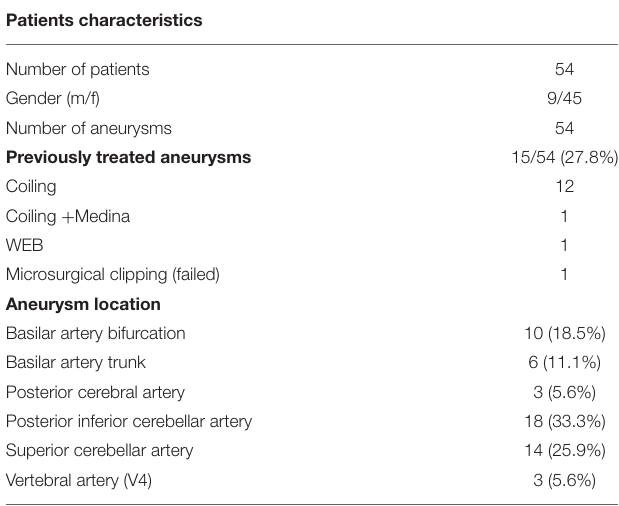
TABLE 1 | Baseline patient demographics and clinical presentation of the study